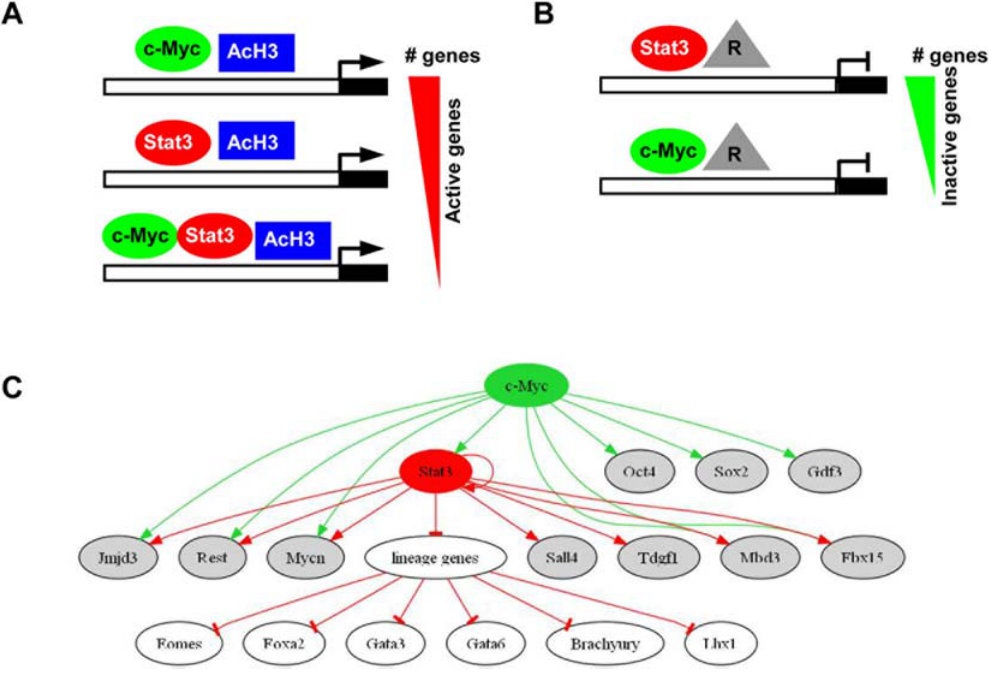
Figure 8. Interaction of Stat3 and c-Myc transcription factors with promoters of ES cell enriched and lineage specific genes. Transcriptional regulation of c-Myc and Stat3 target genes in ES cells. (A) Actively transcribed c-Myc and Stat3 targets are associated with regions of AcH3. c-Myc occupies a greater number of active genes than Stat3; Stat3 and c-Myc co-occupy a number of ES cell enriched genes. The red triangle represents highly expressed genes in ES cells. (B) Inactive genes occupied by Stat3 and c-Myc are bound by polycomb group proteins and are associated with regions of repressive histone modifications. The gray triangle labeled [R] represents repressive proteins and histone modifications. Stat3 occupies a greater number of inactive genes in ES cells relative to c-Myc. The green triangle represents inactivate genes in ES cells. (C) Transcriptional regulatory circuit of Stat3 and c-Myc bound genes.